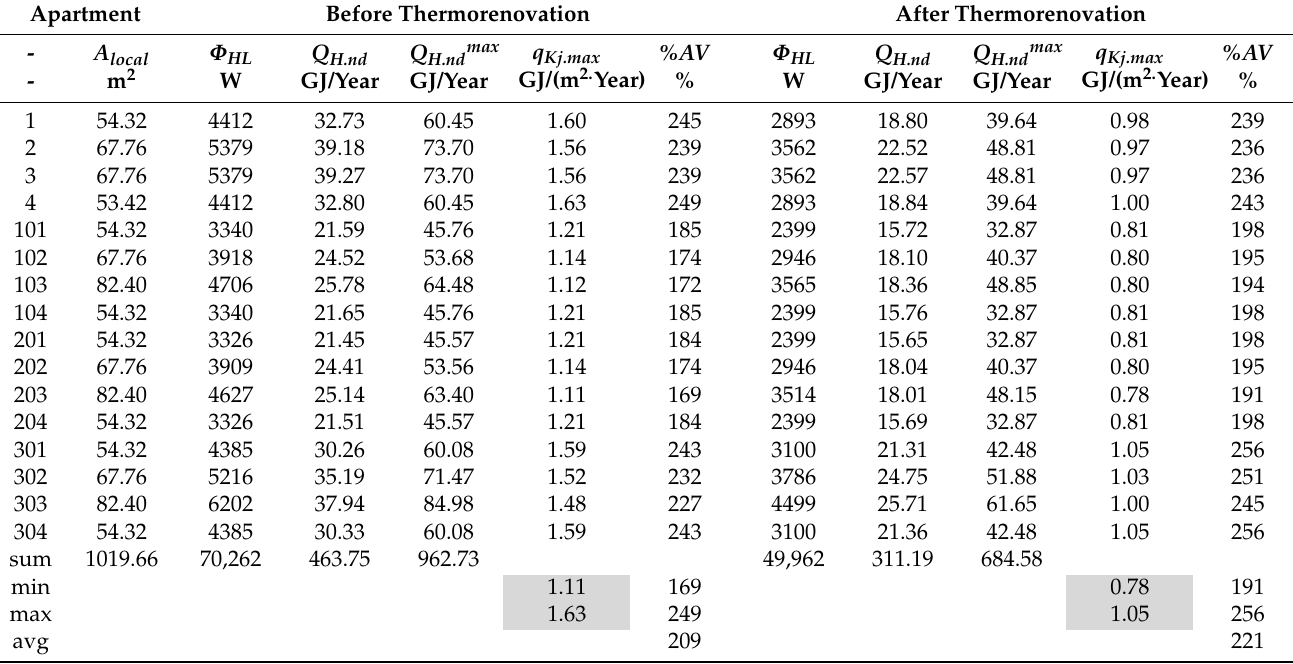
Table A1. The results of the unit maximum final energy consumption in the individual apartments of the analyzed building before and after thermorenovation.